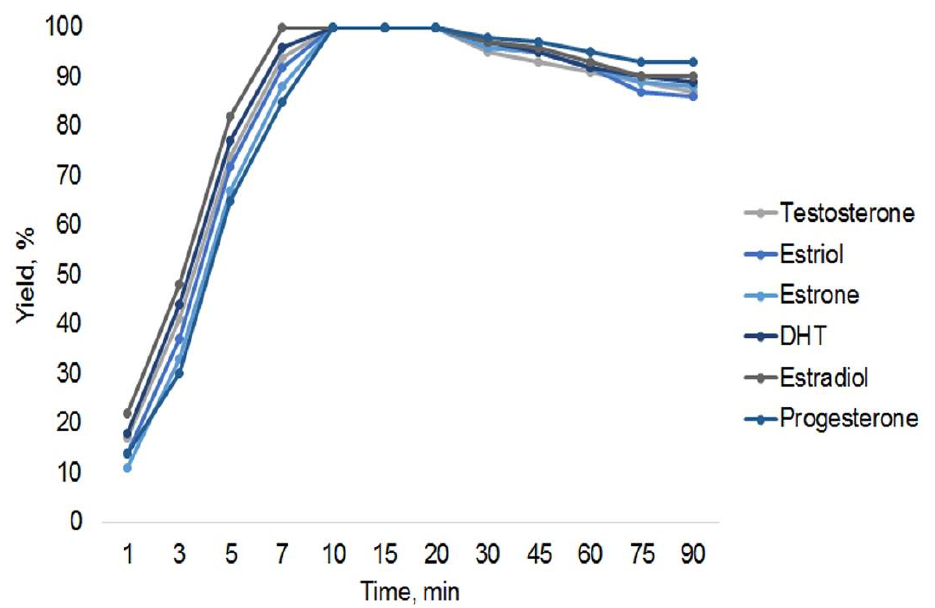
Figure 1. Influence of derivatization time on yield of derivatives obtained with SPAD sample prep- aration.